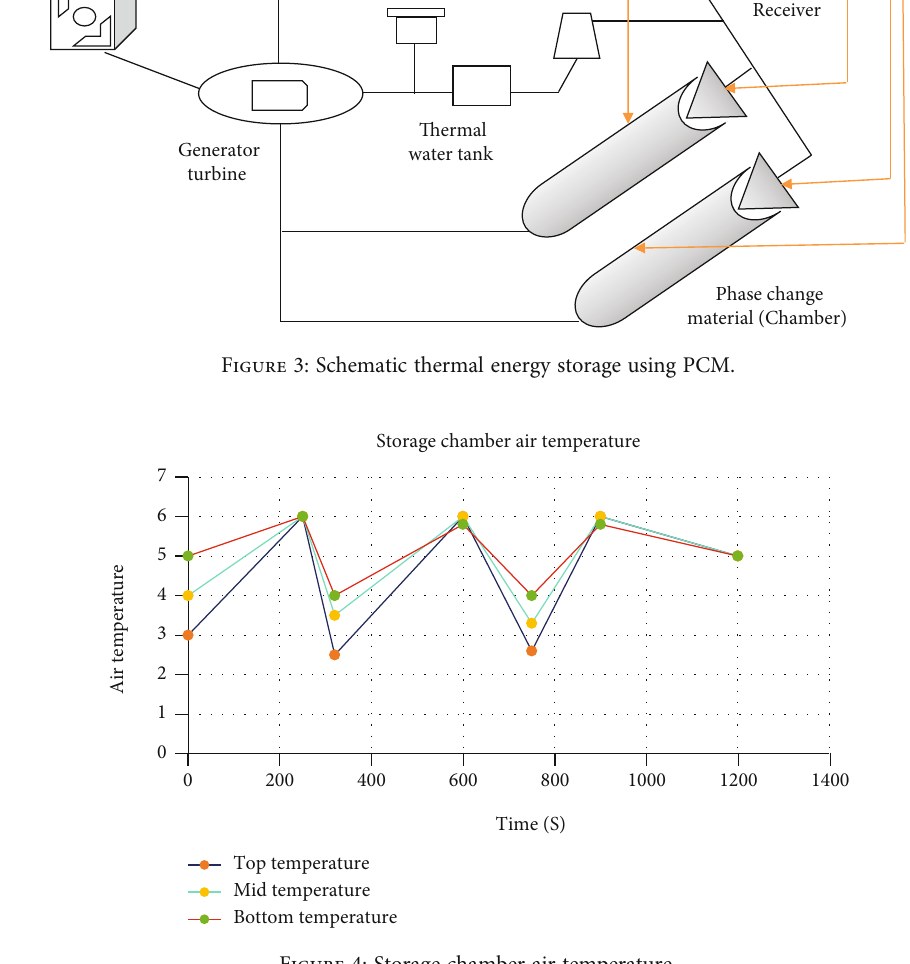
Figure 4: Storage chamber air